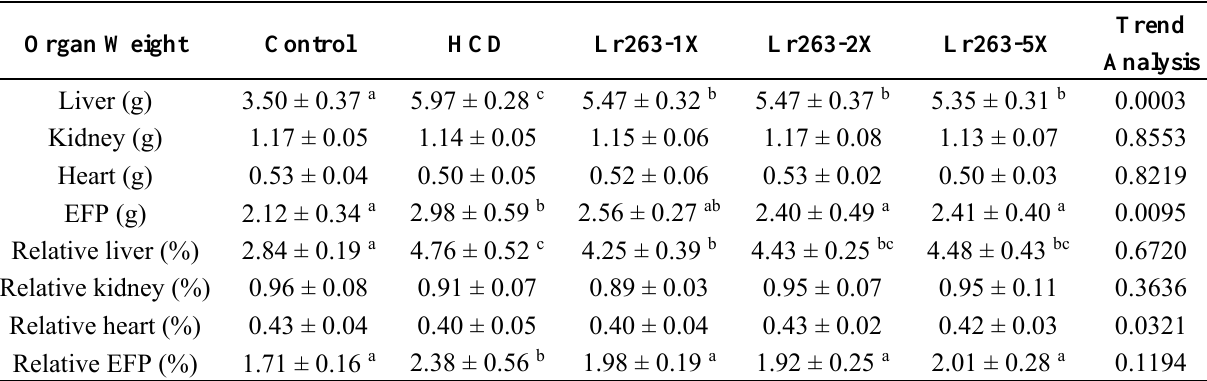
Table 2. Tissue weights at the end of the